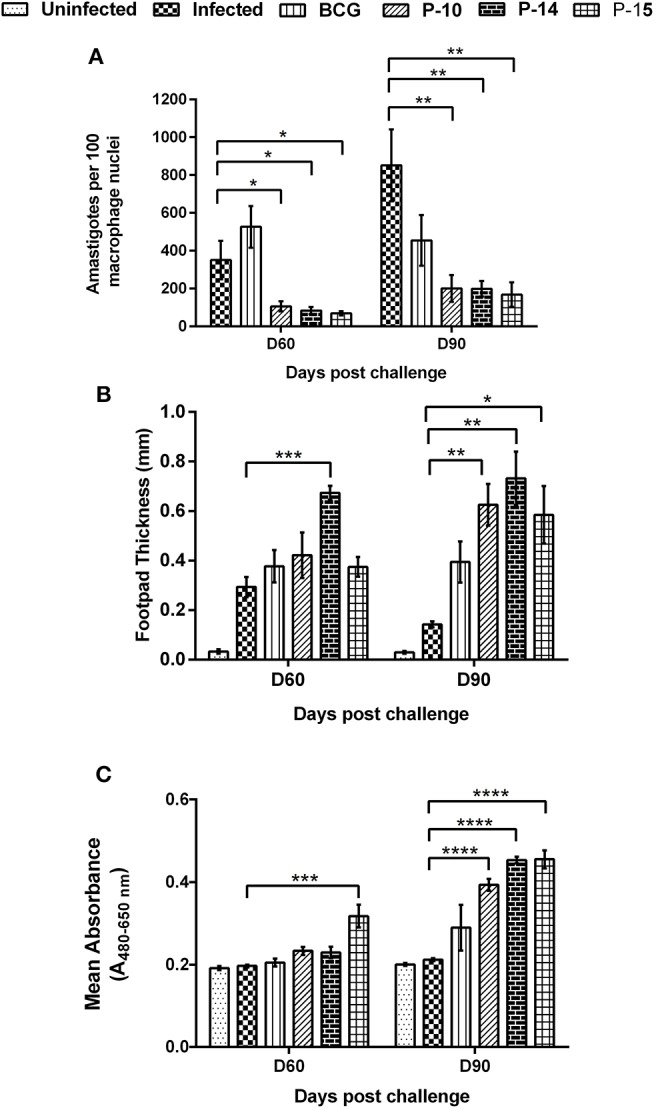
Parasite load in splenic dab smear of vaccinated hamsters (A), DTH response to SLD as footpad swelling (B) and lymphoproliferative response in vaccinated hamsters against SLD (C) in comparison to the unimmunized infected hamsters on days 60 and 90 p.c. One-way ANOVA was used to calculate the statistical significance between the vaccinated and infected group (*p < 0.05; **p < 0.01; ***p < 0.001, and ****p < 0.0001).